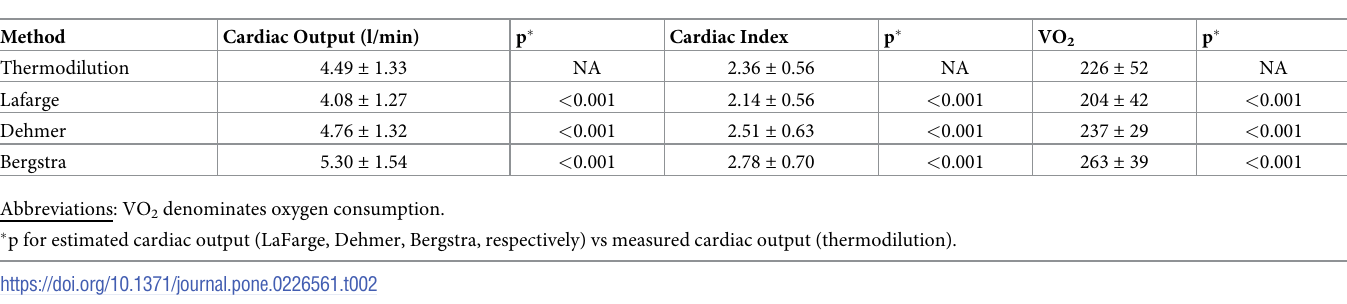
The correlation between CI-TD and CI-eFM in patients with none- or mild and moderate valve regurgitation did not differ relevantly. The mean difference between CI-TD and the CI- eFM as assessed by La was lower in patients with severe tricuspid regurgitation (0.048 ± 0.447 vs 0.256 ± 0.440, p = 0.028), while it did not differ when CI-eFM was assessed by De or Be. Excluding patients with severe tricuspid regurgitation improved the coefficient of